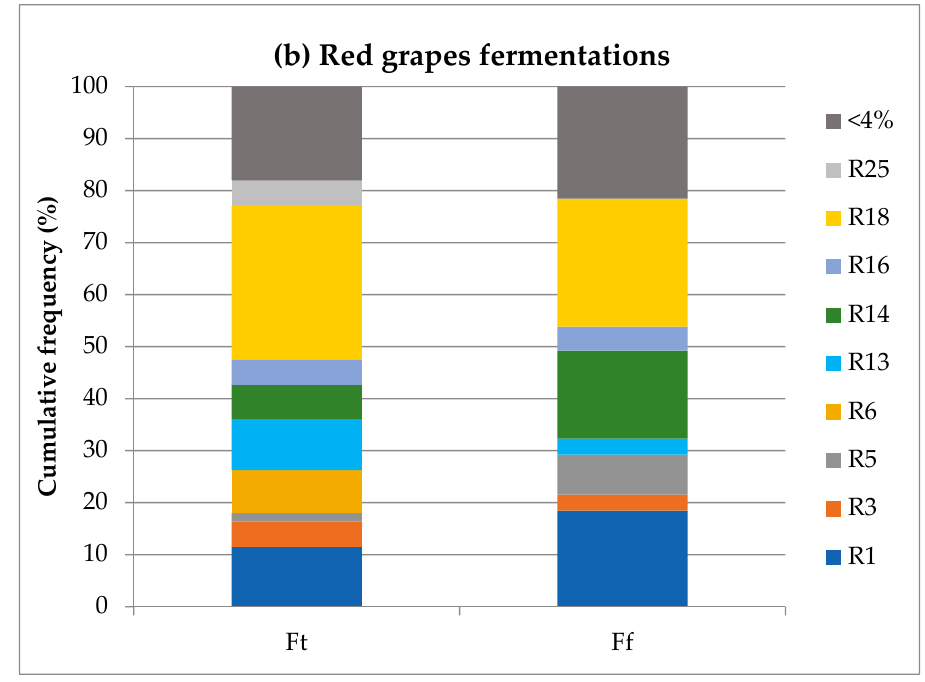
Figure 4. Dynamic of S. cerevisiae strains population during 2015 white must ( a ) and red grapes ( b ) fermentations in Pazo de Vieite. m-must; Fi, Ft, and Ff-initial, tumultuous and final stages of fermentation. <4%- Σ frequencies of those strains that appeared at frequencies <4%.